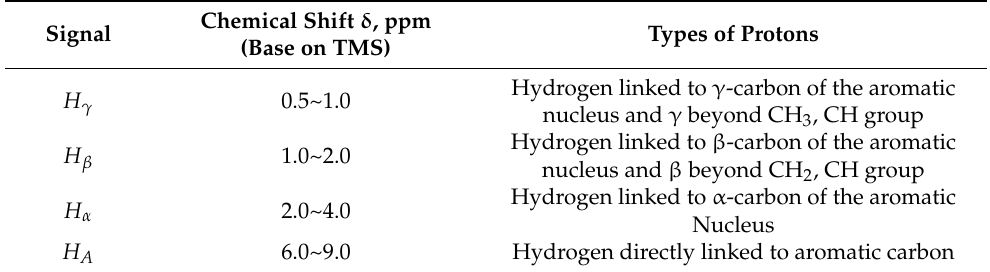
Table 2. Types of protons in the 1 H-NMR spectrum.